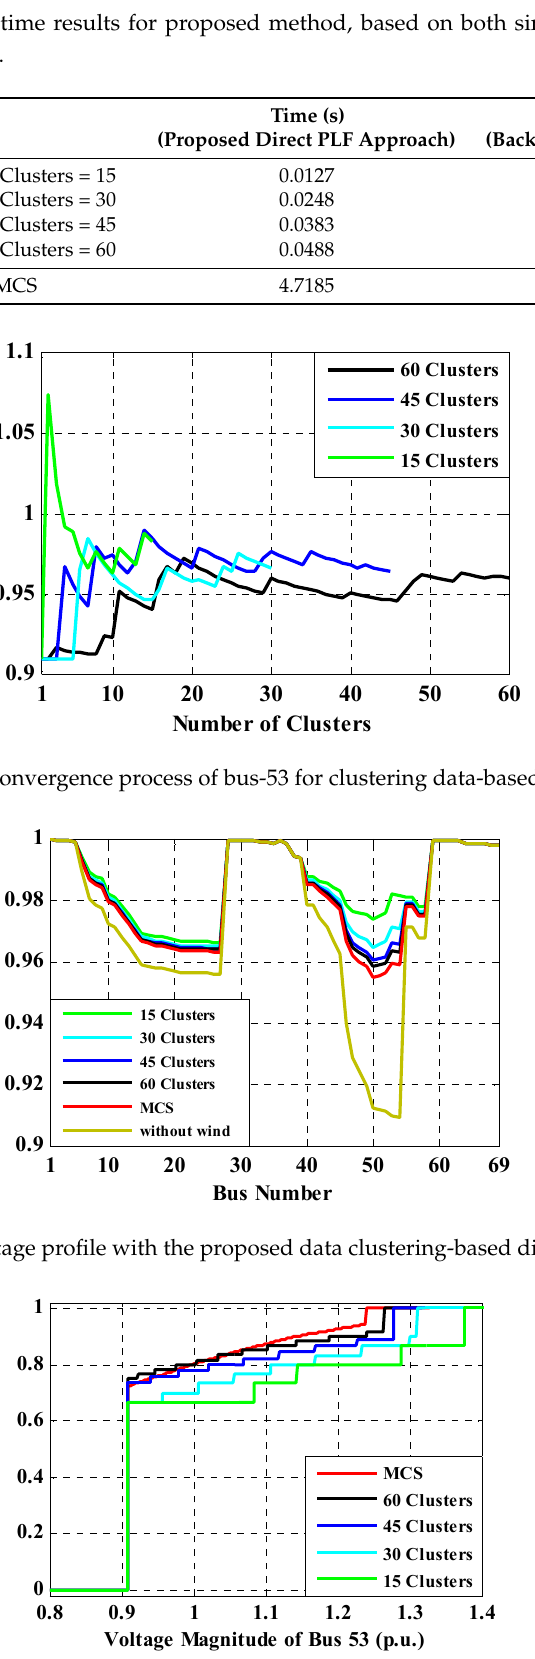
Figure 15. Cumulative distribution function (CDF) of voltage magnitude for bus-53.